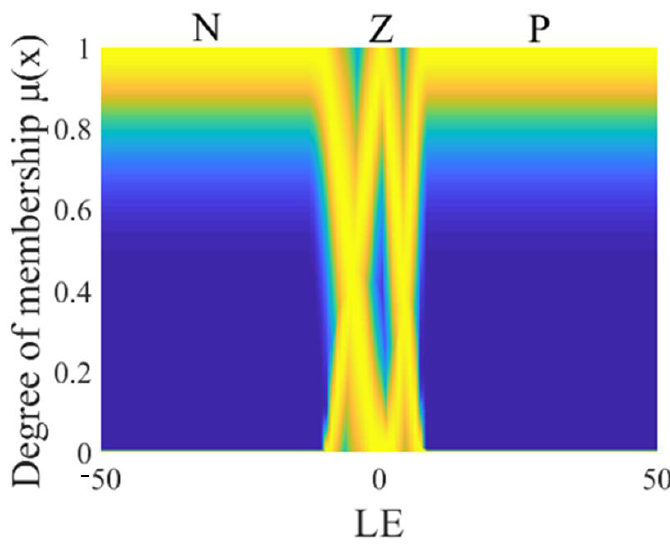
Figure 4. Antecedent of the GT2FC.